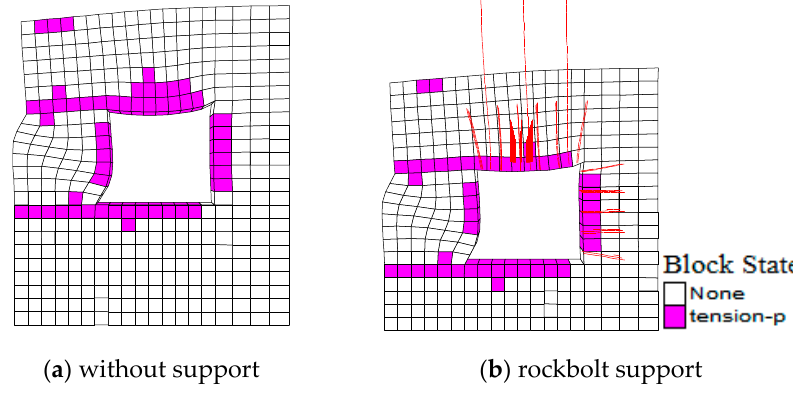
Figure 13. Tensile failure distribution of GER surrounding rock.